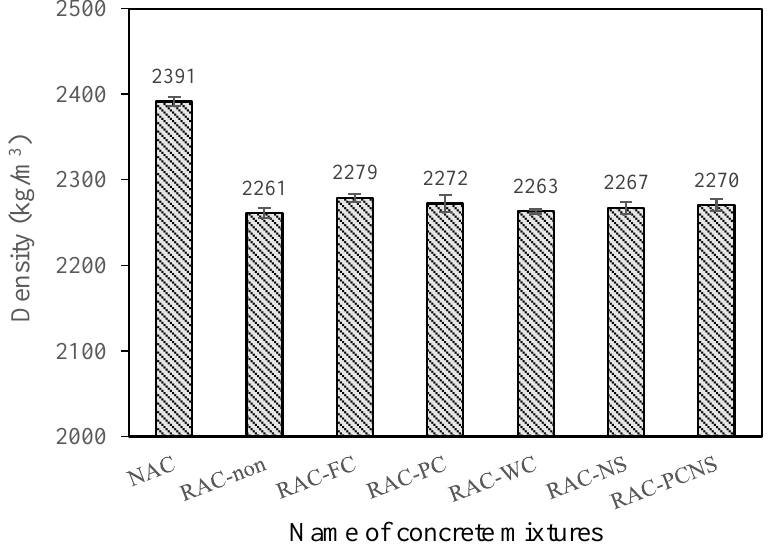
Figure 4. Densities of hardened concretes.